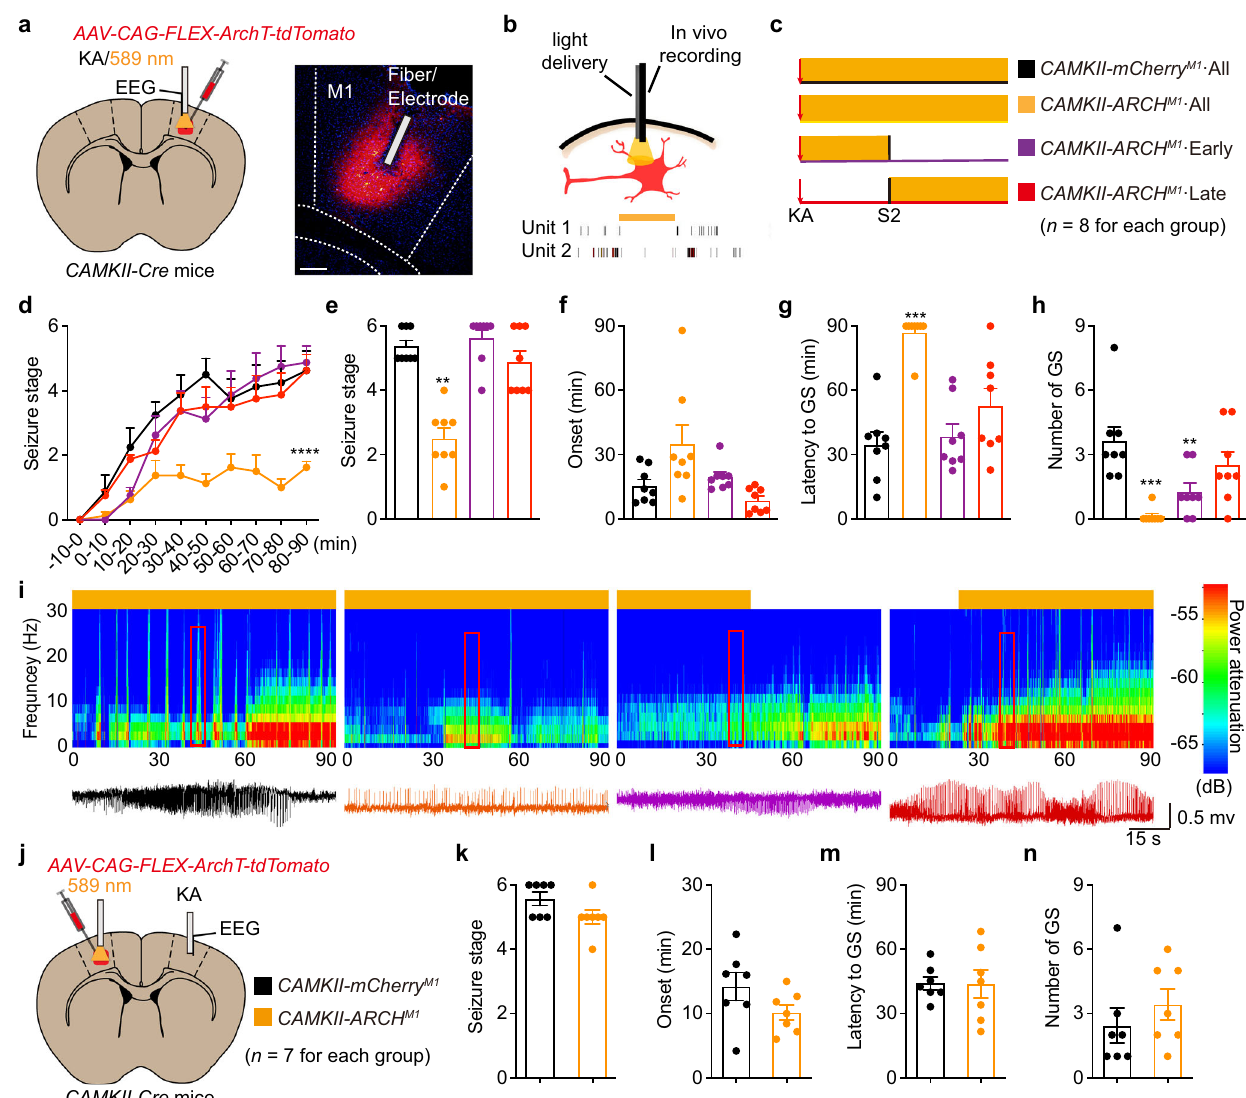
Fig. 3 | Optogenetic inhibition of pyramidal neurons attenuates neocortical seizures with narrow therapeutic window. a Left panel, schematic of viral injection, stimulation and EEG recording in RM1 of CAMKII-ARCH M1 mice. Right panel, fl uorescent image showed restricted expression of ArchT-tdTomato in M1. Scale bar, 200 μ m. b Representative spikes of M1 pyramidal neurons showing the reduced fi ring rate in response to yellow light stimulation. c Paradigms of yellow light stimulation in different phases in KA-induced seizures. d Effects of optoge- netic inhibition of RM1 pyramidal neurons on the development of seizure stage during 90min after KA injection. e – h Effects of different-phase optogenetic inhi- bition of RM1 pyramidal neurons on seizure stage ( e ), EEG onset ( f ), latency to GS